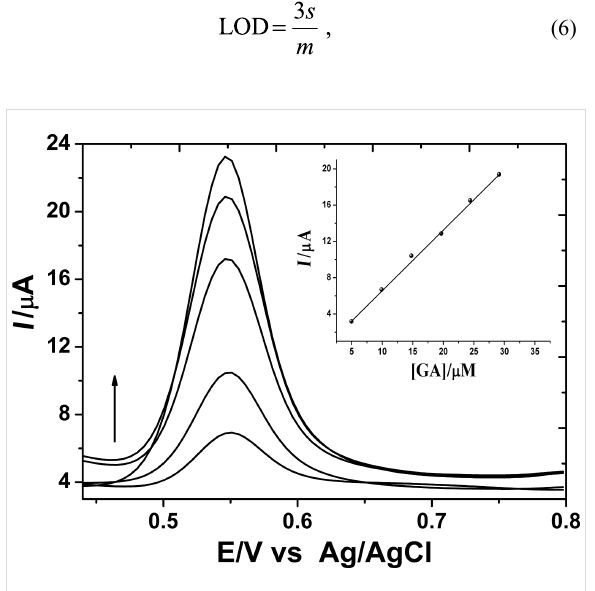
Figure 6: SW voltammograms obtained at optimal conditions in 0.2 M H 3 PO 4 solution containing different GA concentrations. Inset: analyti- cal